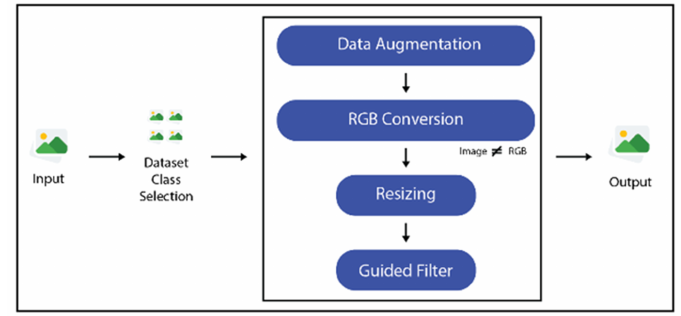
Figure 3. Preprocessing.